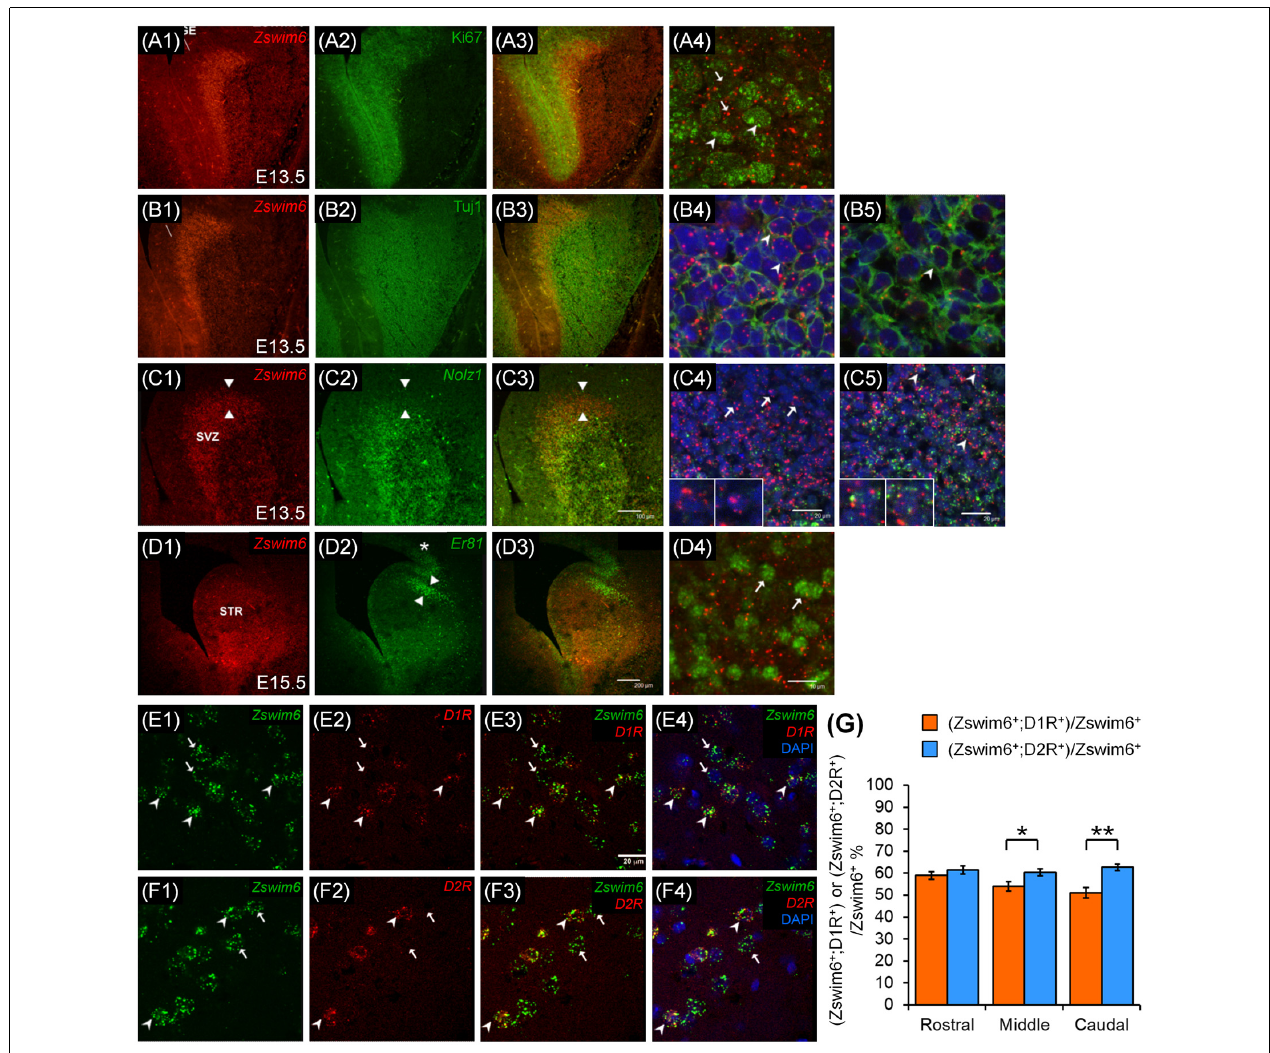
FIGURE 10 | Zswim6 are expressed in Nolz1-positive neurons in the LGE at E13.5 and striatonigral and striatopallidal neurons in adult brains. Zswim6 is mainly expressed in the SVZ of the LGE at E13.5 (A1,B1) , whereas Ki67-positive (A2) and Tuj1-positive (B2) cells are located in the VZ and the MZ of the LGE, respectively. In the overlapping zone (A3) , Zswim6 -positive cells express none or at most low levels of Ki67 (arrows, A4 ). Cell expressing high levels of Ki67 contained none or low levels of Zswim6 (arrowheads, A4 ). Colocalization of Tuj1 protein and Zswim6 mRNA (B3) is detected in cells of SVZ (B4) and MZ (B5) . (C,D) Both Zswim6 (C1) and Nolz-1 (C2) are expressed in the SVZ of LGE, and their expression domains are mostly overlapped in the ventral part of SVZ (C3) . In the dorsal non-overlapping zone, cells expressing Zswim6 without Nolz-1 are present ( C3 , the area between arrowheads; C4 , insets show high magnification of the cells indicated by arrows). In the Zswim6 and Nolz-1 overlapped regions, Zswim6 is colocalized with Nolz-1 ( C5 , insets show high magnification of cells indicated by arrowheads). At E15.5, Zswim6 mRNA (D1) is expressed in the SVZ of the striatal primordium, while Er81 marks the dorsal-most part of the striatal primordium ( D2 , between arrowheads). Although Zswim6 expression is overlapped with Er81 at the dorsal-most striatum (D3) , at the single-cell level, Zswim6 mRNA signals ( D4 , arrows) are not co-localized with Er81-positive cells. (E,F) Confocal images of double in situ hybridization show that some Zswim6 -positive cells ( E1,E3,E4 ; arrowheads) were co-localized with D1R (E2–E4) in the mature striatum, whereas others express Zswim6 only ( E1,E3,E4 ; arrows). In the double in situ hybridization of Zswim6 and D2R , some Zswim6 -positive cells ( F1,F3,F4 ; arrowheads) were co-localized with D2R (F2–F4) in the mature striatum, while others expressed Zswim6 only ( F1,F3,F4 ; arrows). (G) Quantification of the co-localization ratios of Zswim6 and D1R or D2R in the mature striatum from the rostral to caudal levels. * p < 0.05, ** p < 0.001, n = 3, student’s t -test. LGE, lateral ganglionic eminence; MZ, mantle zone; STR, striatum; SVZ, subventricular